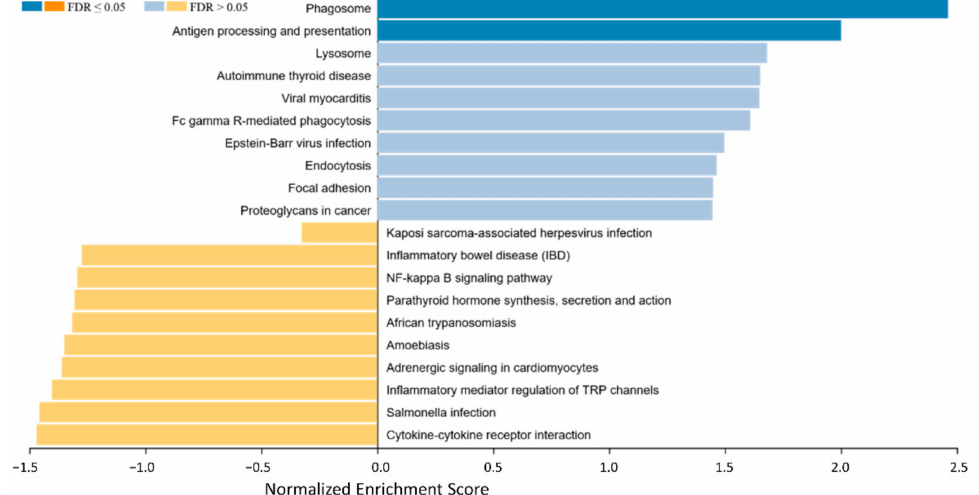
Figure 2. Gene set enrichment analysis of differential expressed genes between EMM and SMMpresenting an overview of gene sets enriched in SMM (right side, blue bars) and EMM (left side, yellow bars). In the SMM the pathways for phagosome, Fc gamma R-mediated phagocytosis, antigen processing and presentation and proteoglycans in cancer show enrichment. Cytokine–cytokine receptor interaction is enriched and thereby potentially activated in